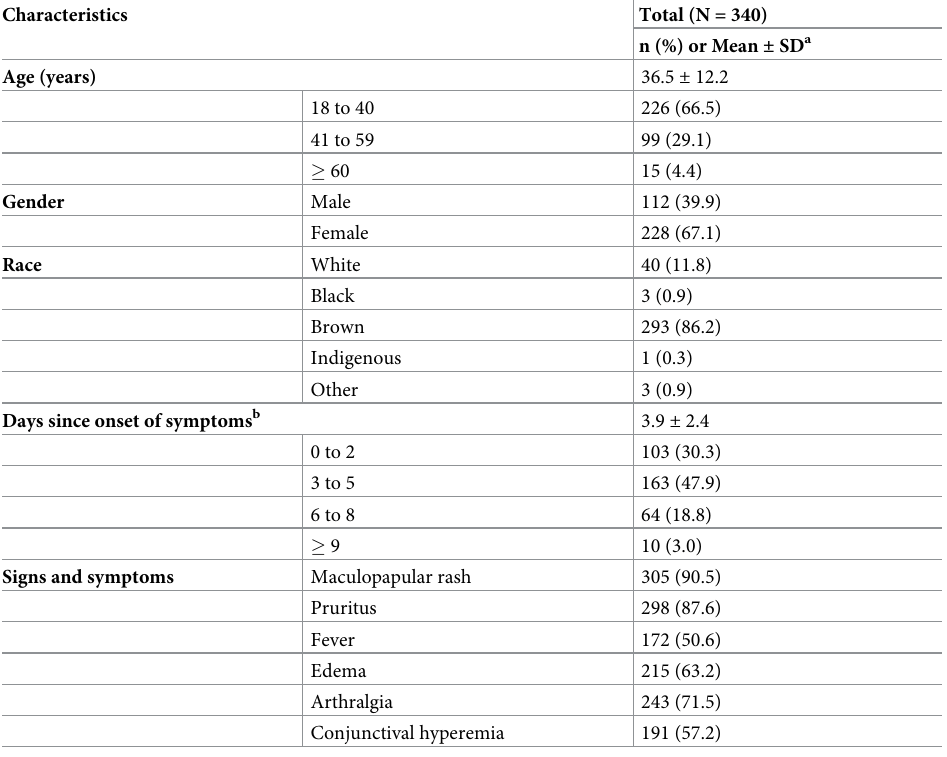
Table 1. Baseline and clinical characteristics of patients with rash, FMT-HVD, Manaus, February 2018 to May 2019.